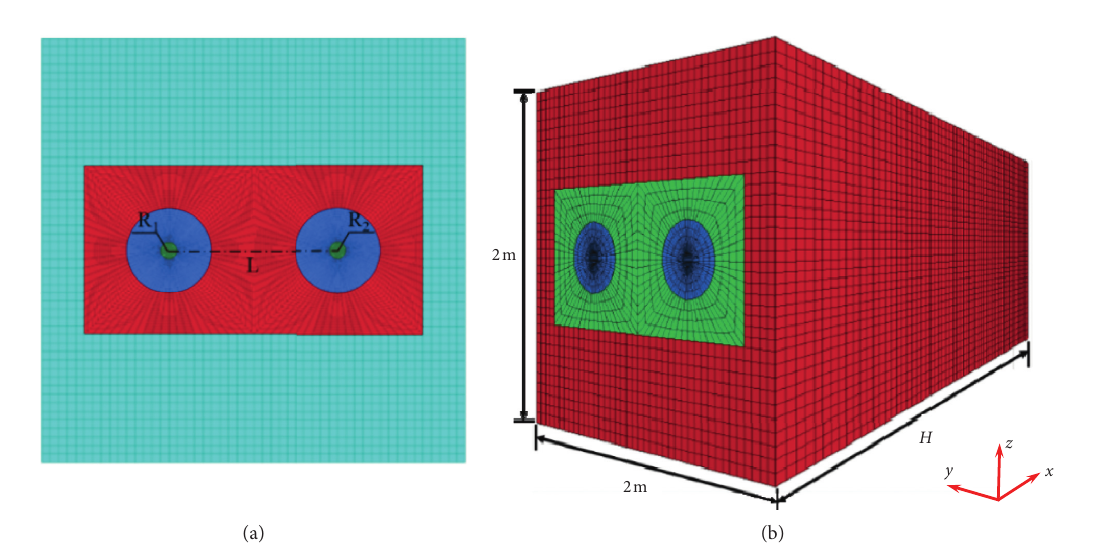
Figure 10: FLAC3D calculation and design model. Table 5: Numerical simulation of physical